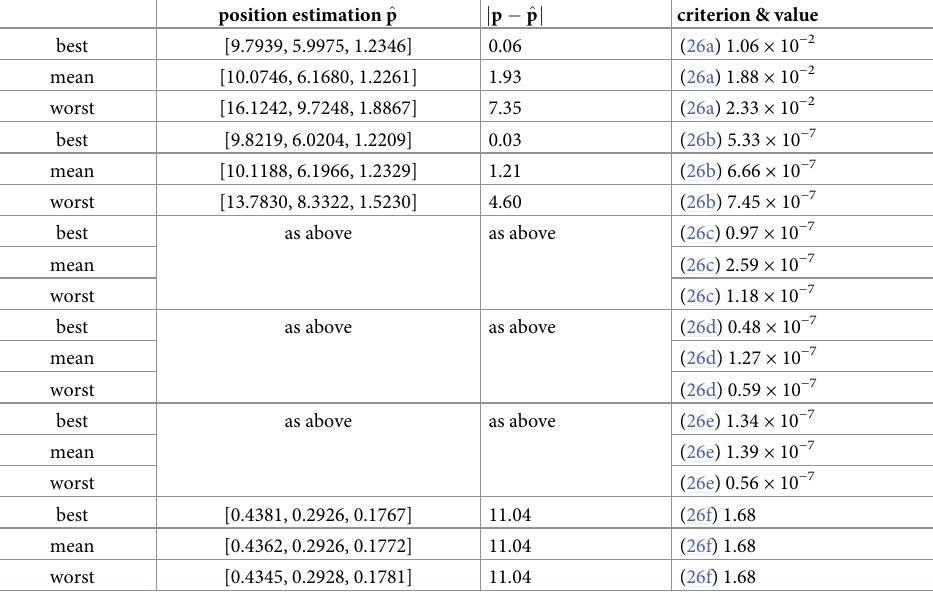
Table 1. Estimation of the object position using algorithm fminsearch with initial estimate ð p = 2 ; � r = 2 Þ and use of noise corrupted references and measurements of all range differences.